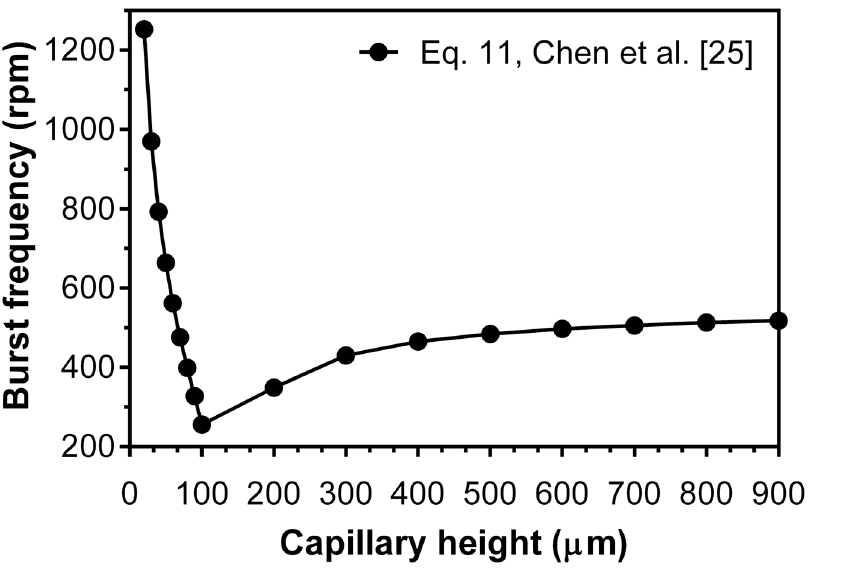
Figure 6. The distribution of the burst frequencies using Eq. 11 [25] versus different capillary height where the capillary width is kept constant of 300 m m for a contact of 70. doi:10.1371/journal.pone.0073002.g006 the right chamber. It flows at the top of the chamber against the